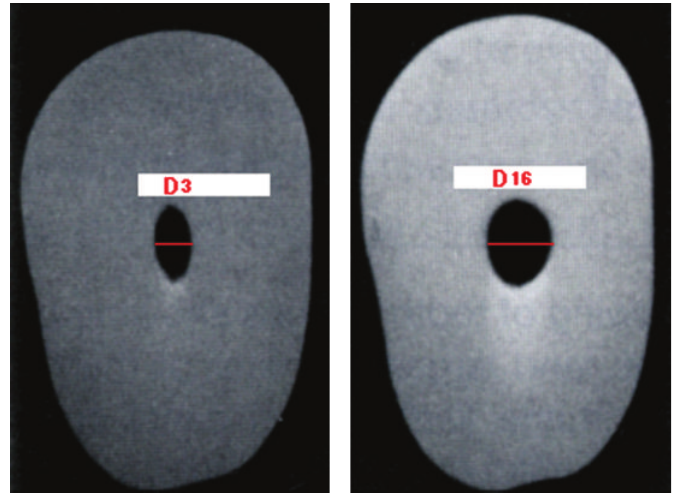
Figure 1: Diameter measure D3 and D16 after root canal